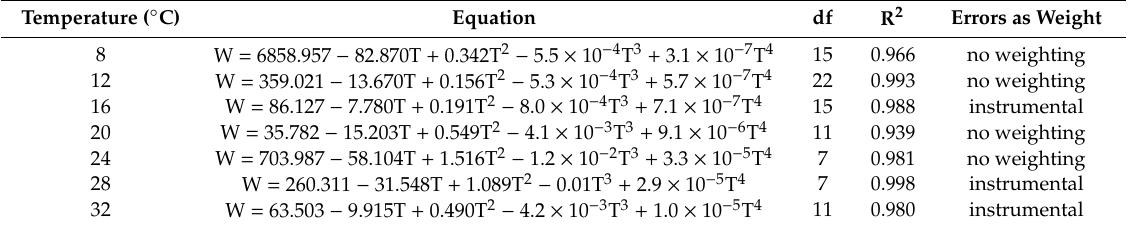
Table 5. Curve fitting equation, degrees of freedom (df), and coe ffi cients of determination (R 2 ) of the relationship between the body weight (mg) (10 / mg) of A. grahami larvae and the time after hatching ( T ) (d) at seven constant